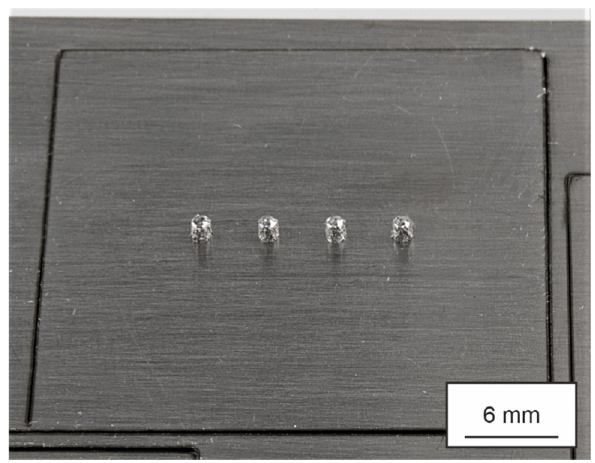
Figure 3: Image of pin Array type 1D - sym - 6 -